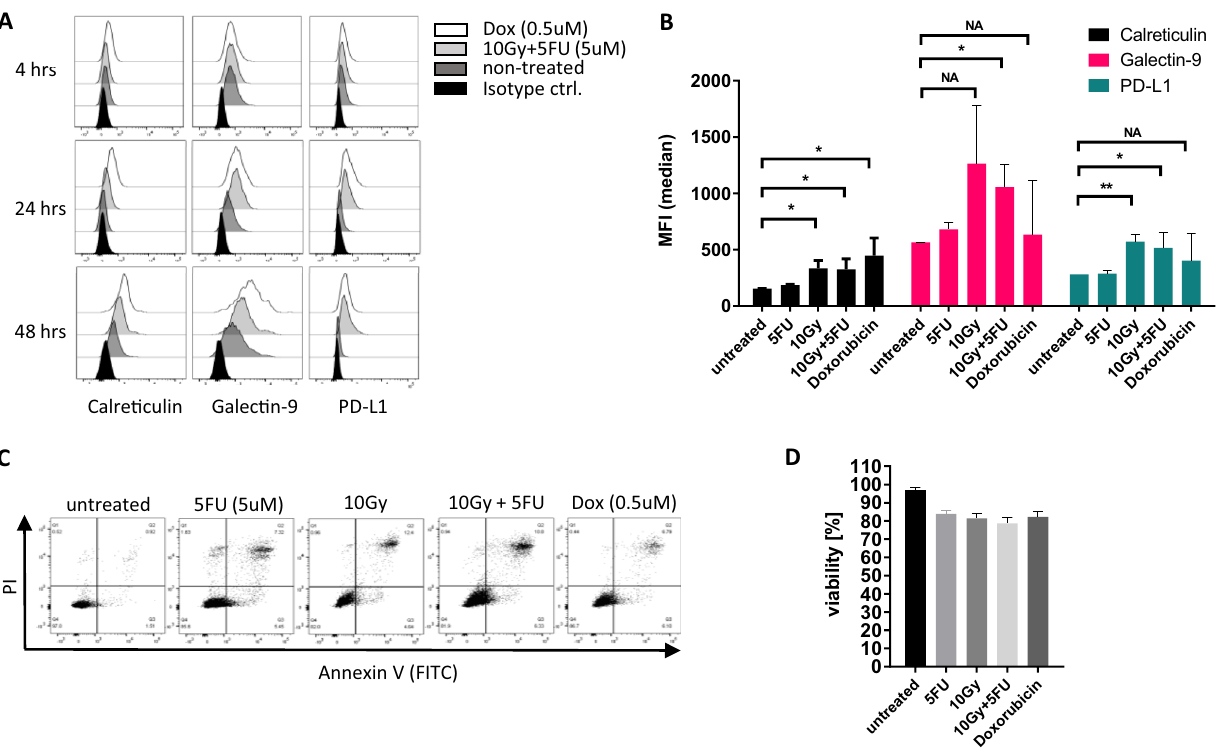
Figure 1. Chemo-/radiation treatment induced ICD in HCT116 cells. HCT-116 cells were treated with a single dose of 5FU (5 μM), X-ray irradiation (10 Gy), chemoradiation or DOXO (0.5 μM) and analyzed using flow cytometry. ( A ) Protein surface expression 4, 24 and 48 h after treatment, ( B ) bar graph of median fluorescence intensity 48 h after treatment, ( C ) apoptosis and ( D ) bar graph of viability 48 h after treatment. Bar graphs display the mean and SEM of at least 3 biological replicates. *P < 0.05, **P < 0.01, ***P < 0.001, NA not applicable (not